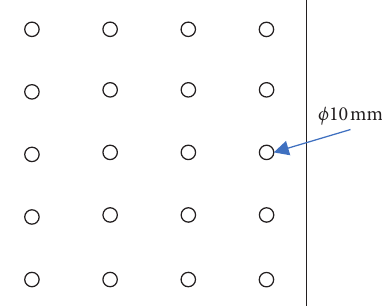
Figure 4: The schematic diagram of punching holes at the bottom of the test box.